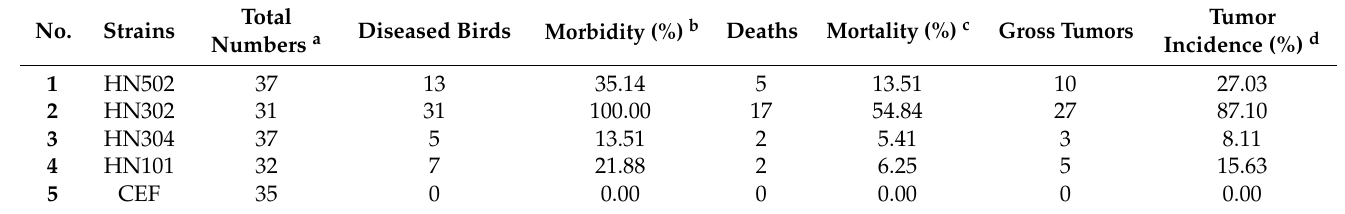
Table 2. Cumulative morbidity, mortality, and gross tumor incidence in birds challenged by different MDV strains calculated at 75 days post-challenge